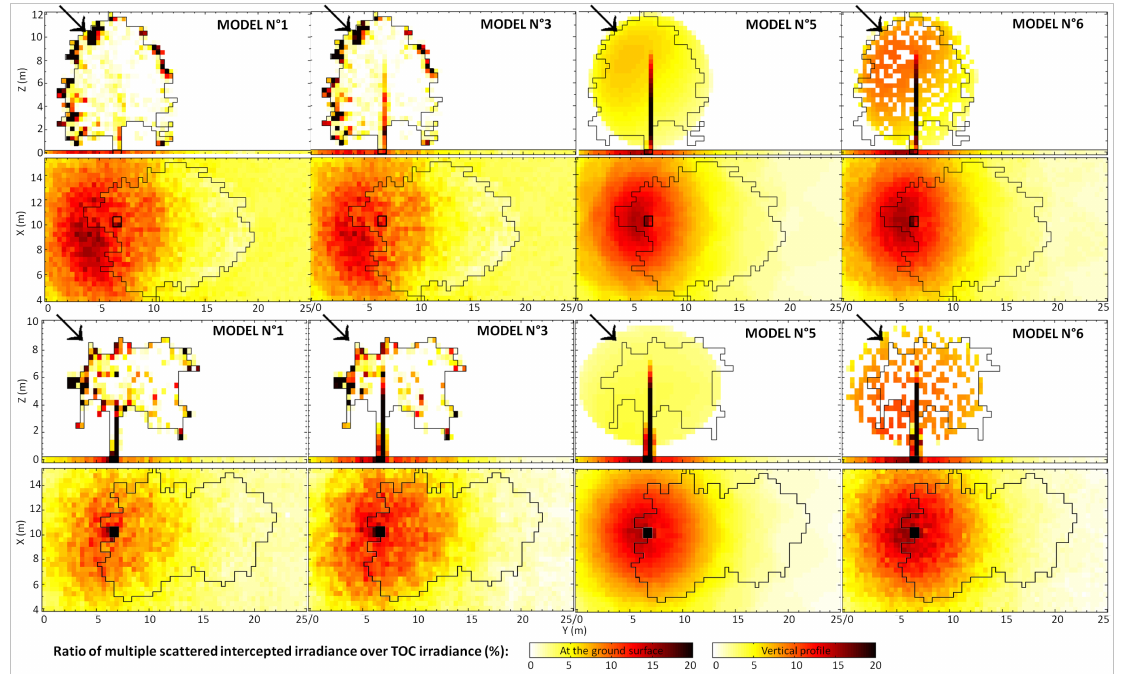
Figure 11. Ratio of the multiple scattered intercepted irradiance over I TOC through a vertical profile at X = 10 m (first/third rows) and T scat computed at the ground surface Z = 0 m (second/fourth rows) for the linden (two first rows) and magnolia trees (two last rows) at 0.8 µ m (SZA = 45 ◦ and BACKGROUND = grass; solar direction indicated by the black arrow, crown spatial extents delineated in black, shadow and trunk location in